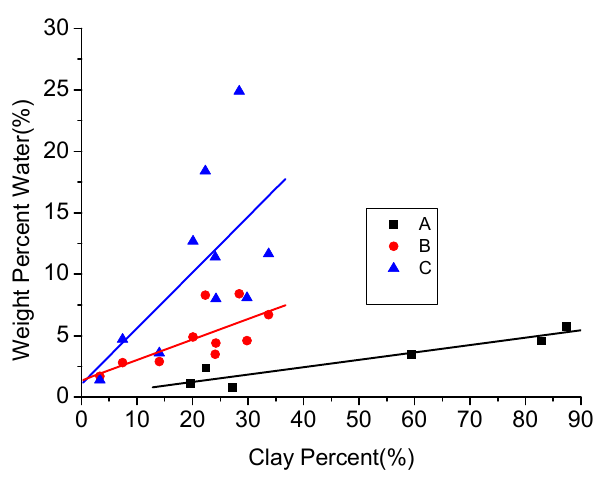
Figure 16. Relationship between clay content and water content [61,77].